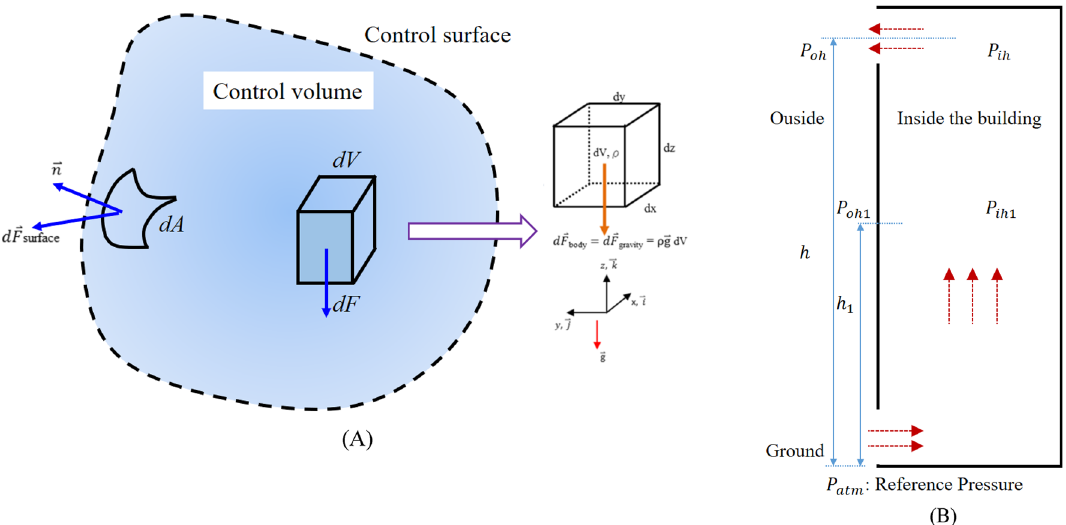
Figure 2. The control volume theory of fluid mechanics ( A ) Force distribution on the fluid. ( B ) Stack effect in a tall building